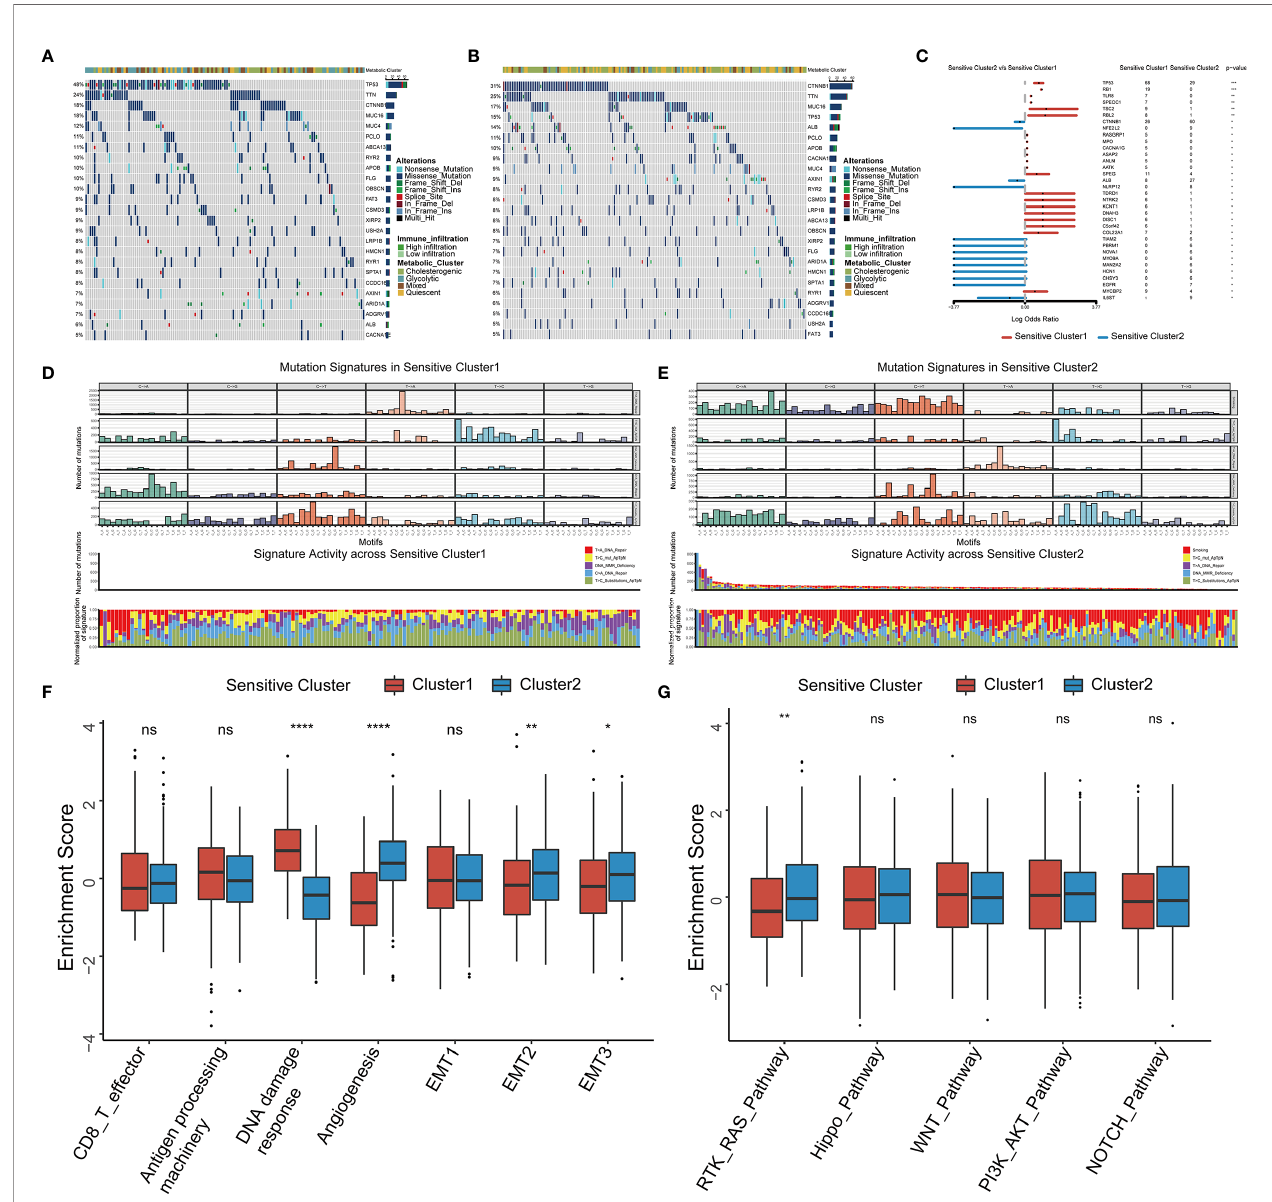
FIGURE 5 | Somatic mutations, mutational signatures, and related signaling pathways for the TTK patterns. (A, B) Waterfall plots revealing the somatic mutation distributions of the 25 genes with the highest mutation frequencies in Cluster 1 (A) and Cluster 2 (B) . (C) Forest plot showing differentially mutated genes in the two clusters. (D, E) Upper panel, Bayesian NMF was used to identify fi ve mutational signatures in Cluster 1 (D) and Cluster 2 (E) . The y -axis shows the number of mutations of each type in each speci fi c sequence. The middle and lower panels show the total number of mutations associated with fi ve mutational signatures (middle) and relative proportion of mutation types (lower panels) in each TTK pattern. (F, G) Differences in signaling pathways involved in patterns of TTK based on gene sets related to stromal-activated pathways and oncogenic signaling cascades. The upper and lower ends of the boxes indicate the interquartile range. Lines in the boxes represent median values, and black dots show outliers. * p < 0.05; ** p < 0.01; *** p < 0.001; **** p < 0.0001; ns, no statistical signi fi